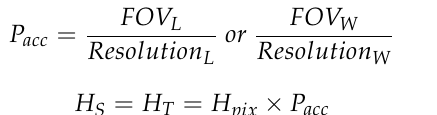
Figure 3. Measurement principle of the proposed method.